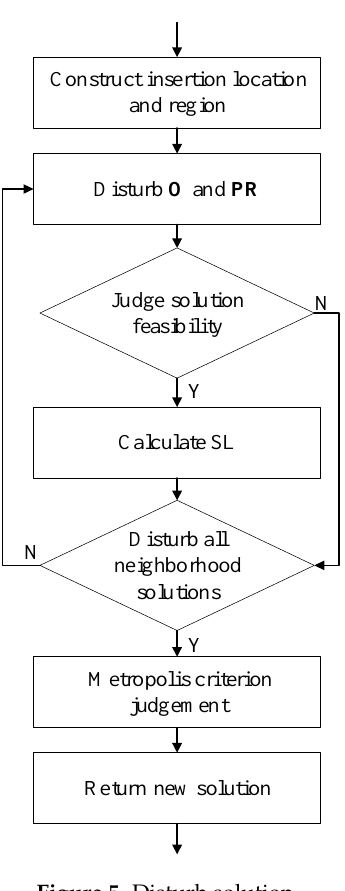
Figure 5. Disturb